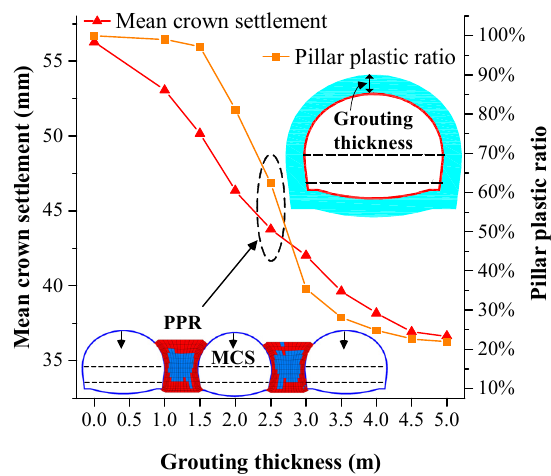
Figure 13. Effect of grouting thickness of curtain grouting pre-reinforcement (CGPR) on MCS and PPR.